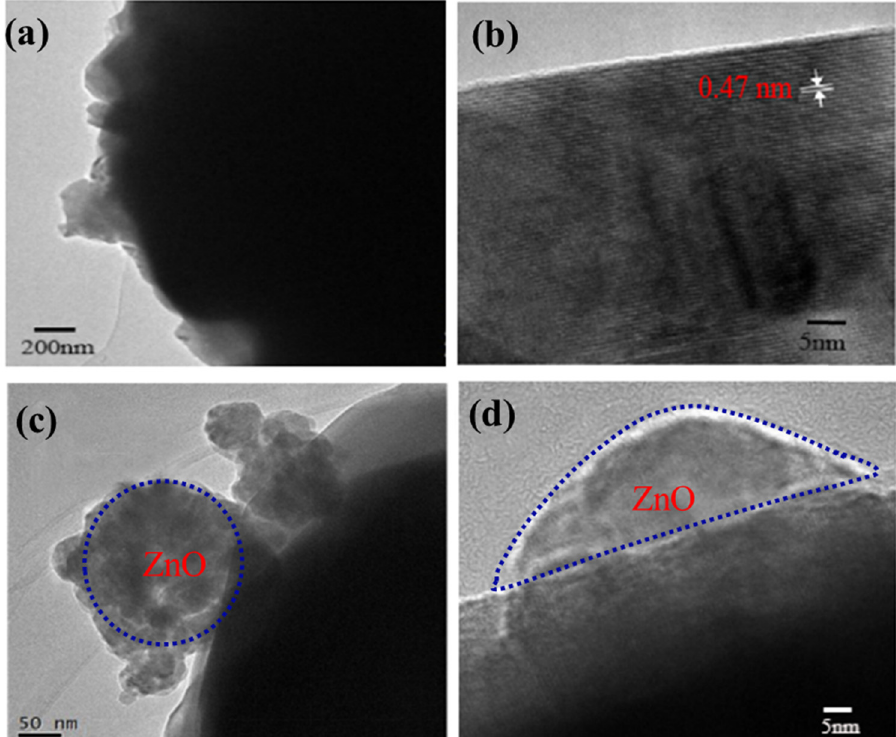
Figure 8: TEM images of ( a and b ) pristine and ( c and d ) ZnO - coated LiNi 0.8 Co 0.15 Al 0.05 O 2 .